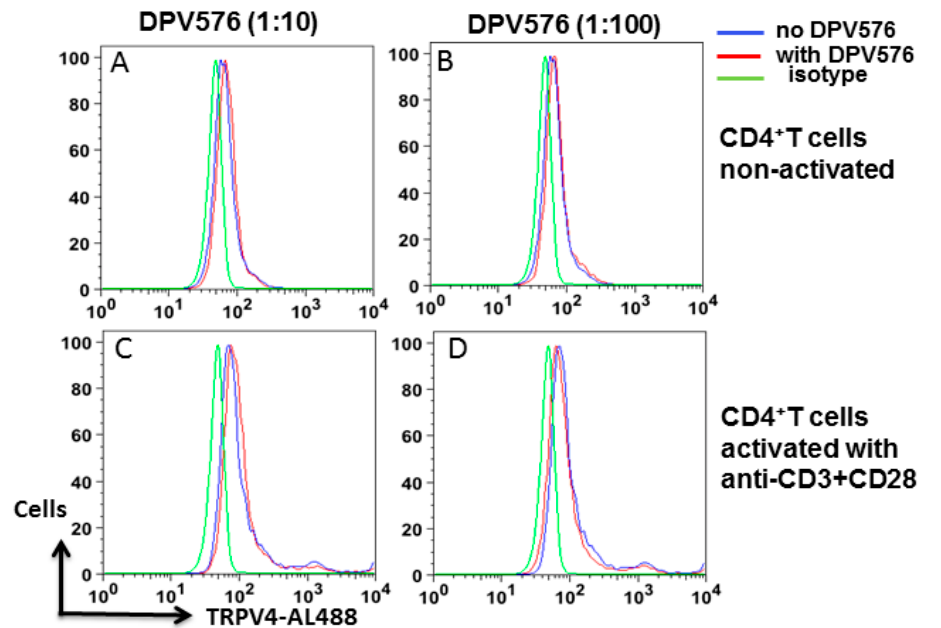
Figure 2. ( A – D ) DPV576 does not modulate the expression of TRPV4 on CD4 + T cells. Inactivated and anti-CD3/CD28 activated CD4 + T lymphocytes were exposed to DPV576 for 24 h. The cells were stained for TRPV channels. Expression of TRPV4 on non-activated T cells ( A , B ). Anti-CD3/CD28 activated T cells ( C , D ). Data is representative of three experiments. Blue: Without DPV576; Red: DPV576 exposed lymphocytes; Green: Isotype.